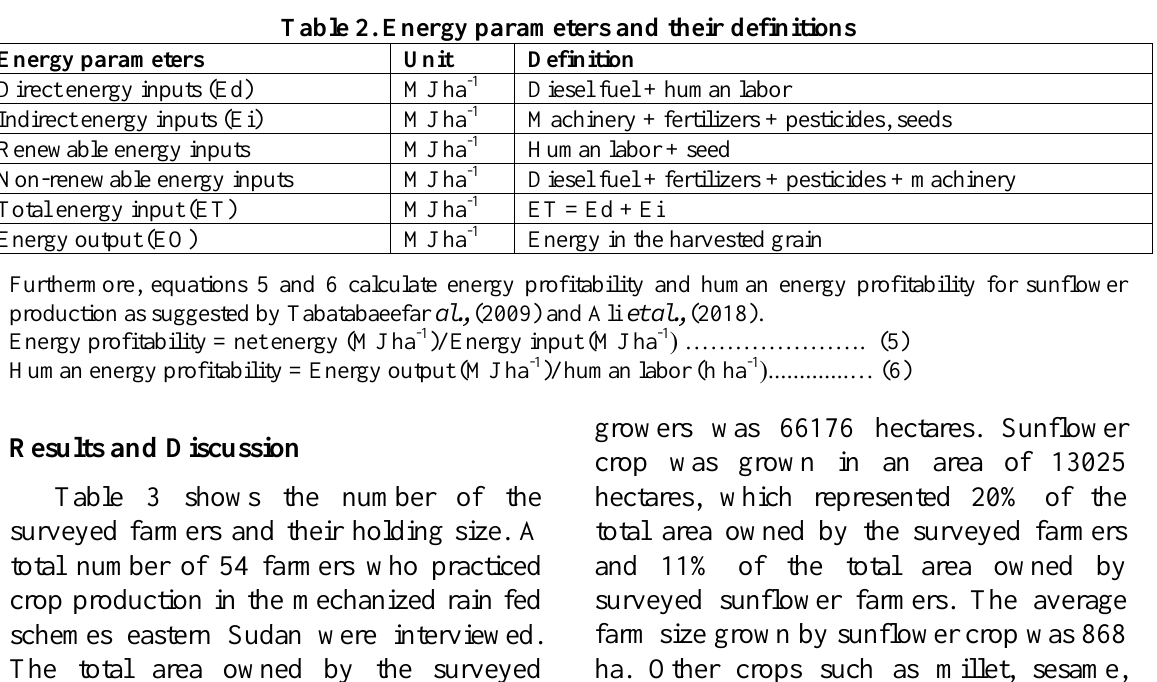
Table 3. The number of the surveyed farmers and the holding size of sunflower farms in the mechanized